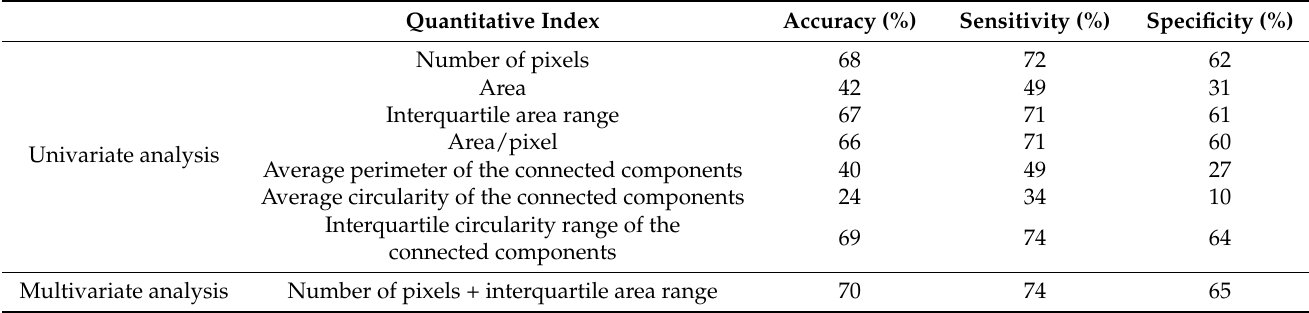
Table 2. Univariate and multivariate analysis (D-100).